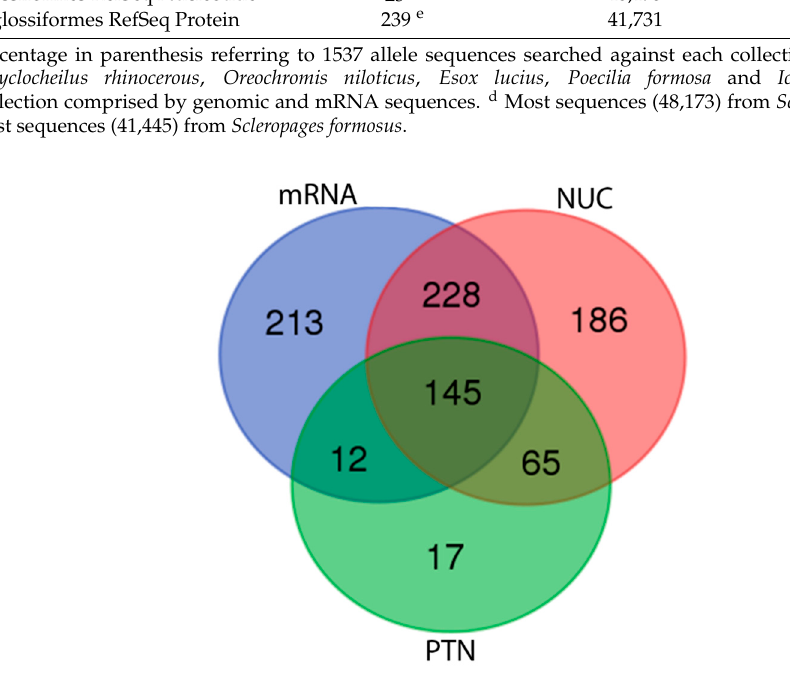
Figure 7. Venn diagram of BLAST hits for 1537 DArTseq allele sequences against three RefSeq fish collections. Details for sequence collections can be viewed in Table 2. NUC: Osteoglossiformes genomic sequences. PTN: Osteoglossiformes protein sequences. mRNA: Teleostei mRNA